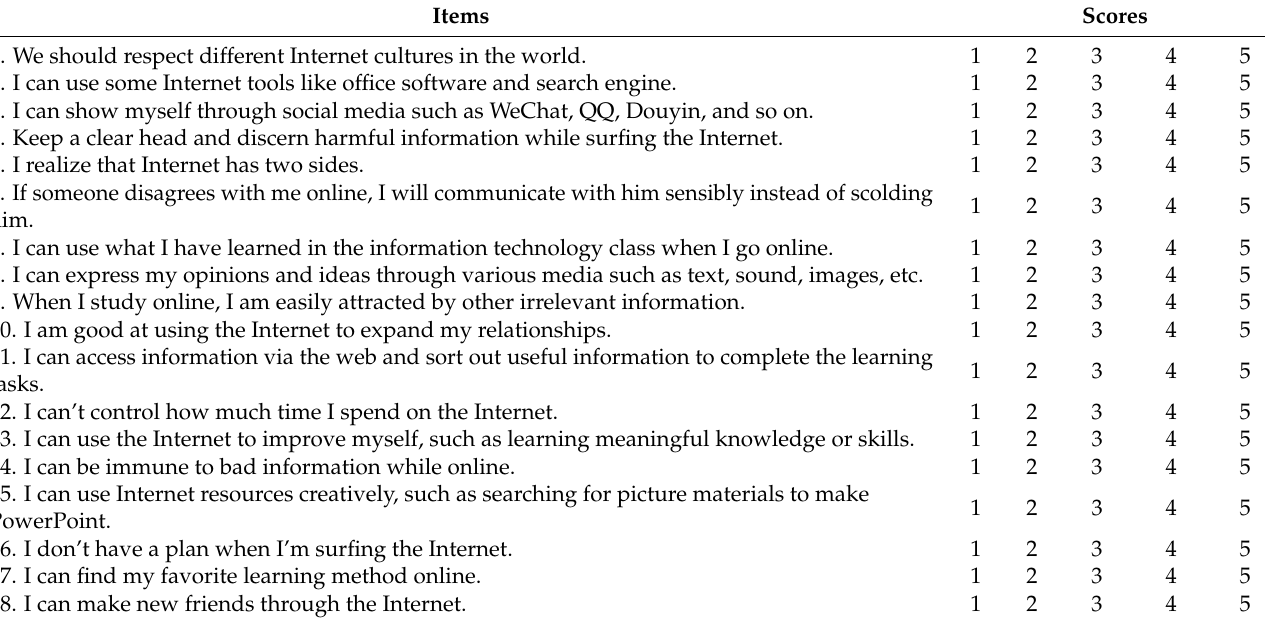
Table A1. The Junior Students’ Internet Literacy Scale (JIL Scale).